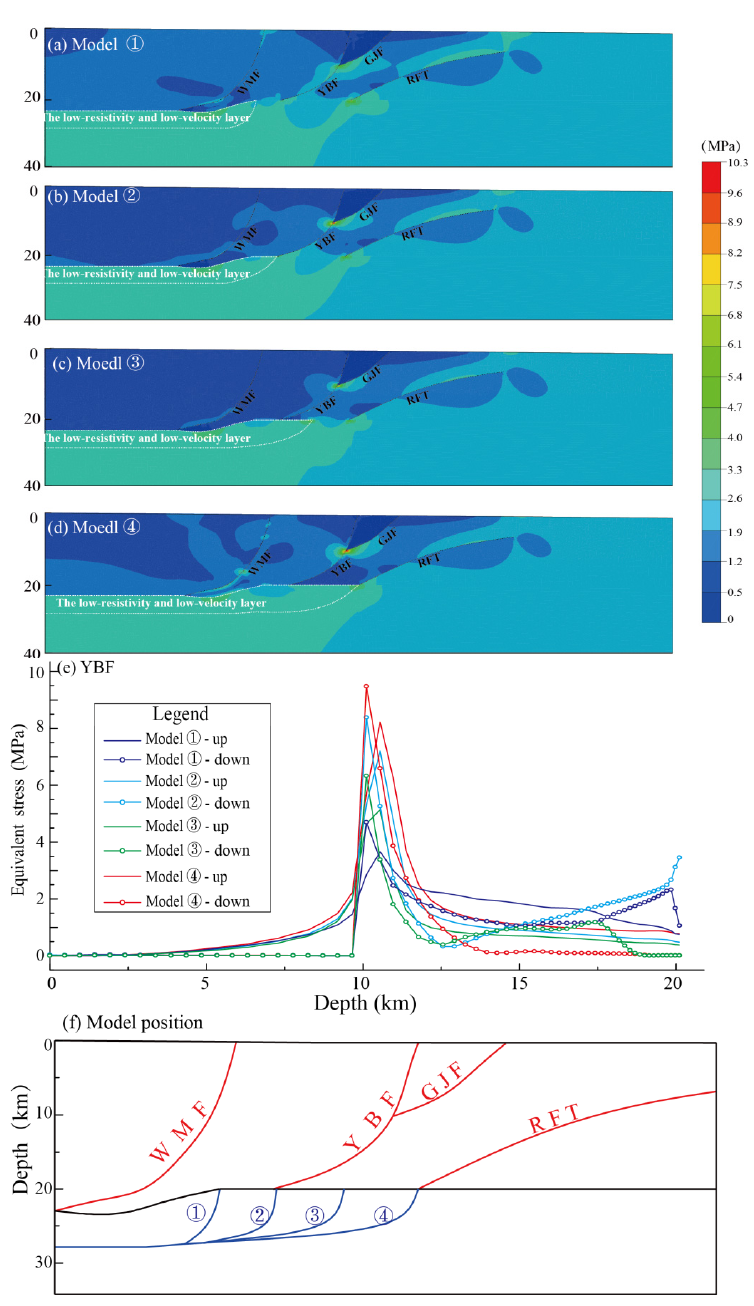
Figure 8. Effect the frontal edge position of the detachment layer on the cumulative equivalent stress distribution in LMS. ( a – d ) are the equivalent stress distribution in LMS under four cases. Black dotted lines: Faults considered in the model; White dotted area: The detachment layer; ( e ) equivalent stress on the YBF; Solid line: Equivalent stress on the hanging wall of the fault; Solid Line with dots: Equivalent stress on the footwall of the fault; Blue color: Results of Model ① ; Cyan color: Results of Model ② ; Green color: Results of Model ③ ; Red color: Results of Model ④ ; Hanging wall of the fault is simplified to “up” and footwall of the fault is simplified to “down” in the legend; ( f ) is the frontal edge position of the four cases.